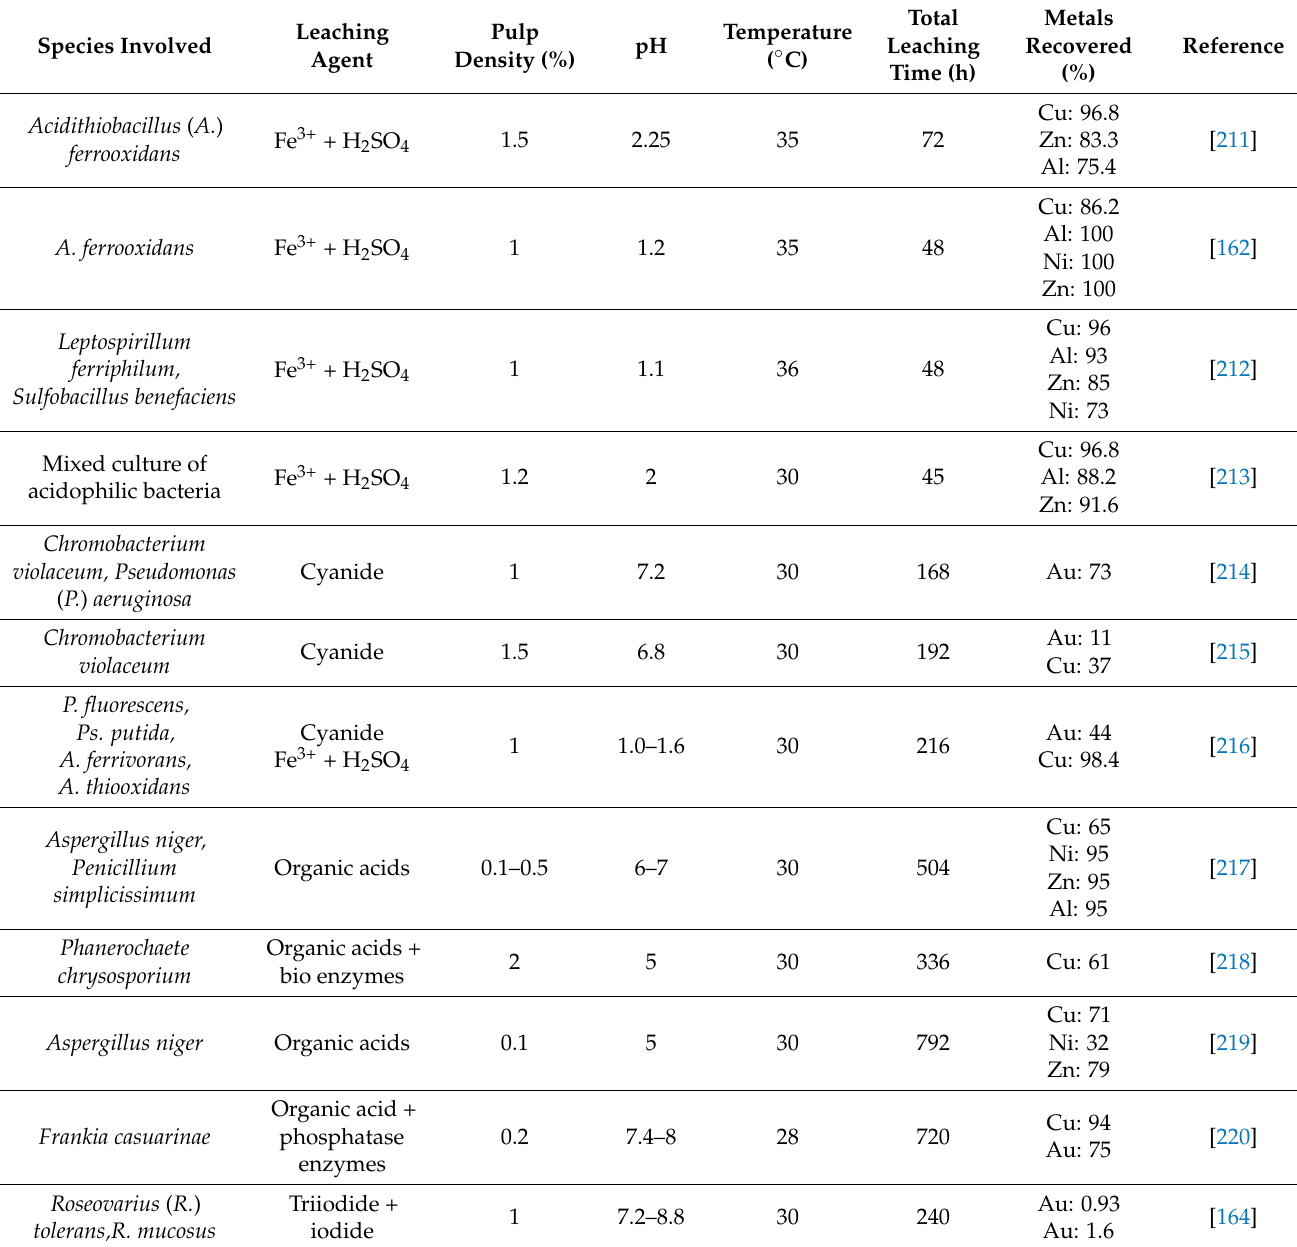
Table 6. Overview of some of the microorganisms used in biohydrometallurgy along with the reagents generated and the process